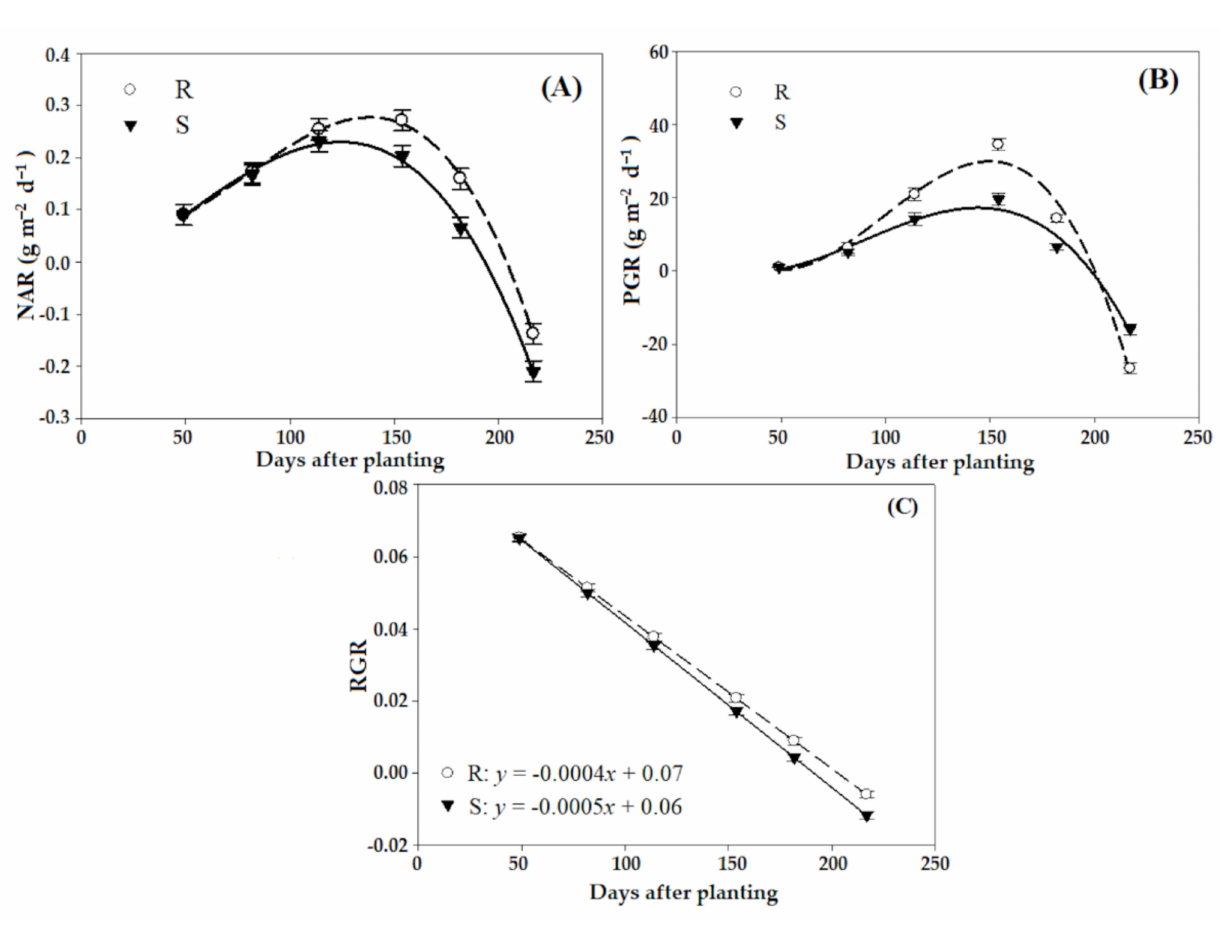
Figure 2. Changes in growth characteristics of resistant (R) and susceptible (S) P. brachystachys sub- populations to the ACCase-inhibiting herbicides at different days after planting. ( A ) Net assimilation rates (NAR), ( B ) plant growth rates (PGR), and ( C ) relative growth rates (RGR) of populations. Table 2. Parameters of the beta model for net assimilation rate (NAR) and plant growth rate (PGR) of resistant (R) and sub-susceptible (S) P. brachystachys populations to the ACCase-inhibitors. Parameters 1 Trait Population R 2 p -Value * A